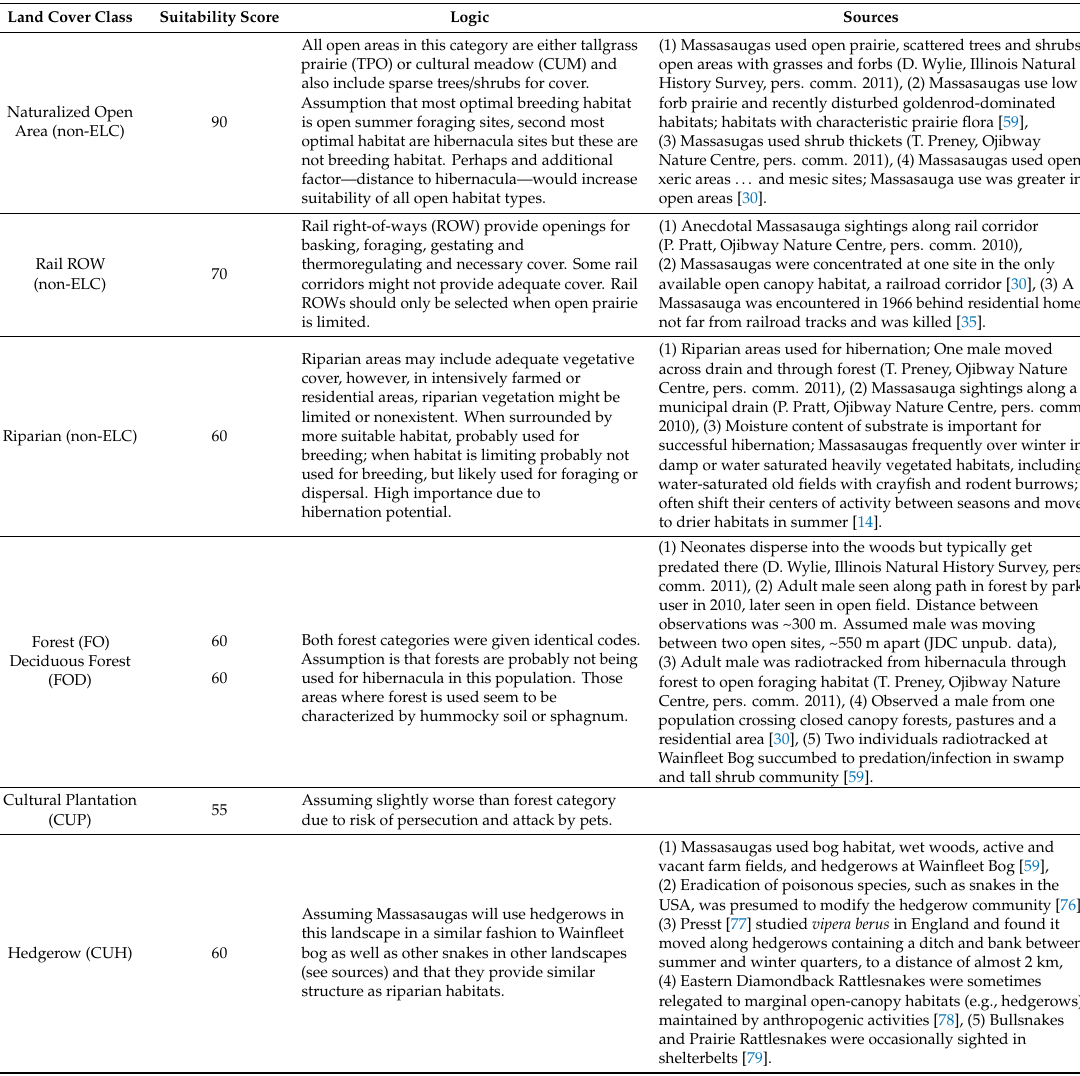
Table A1. Land cover classes used, with logic surrounding choice of suitability scores, to develop a habitat suitability model for the Massasauga ( Sistrurus catenatus ) in an urban landscape in southwestern Ontario,